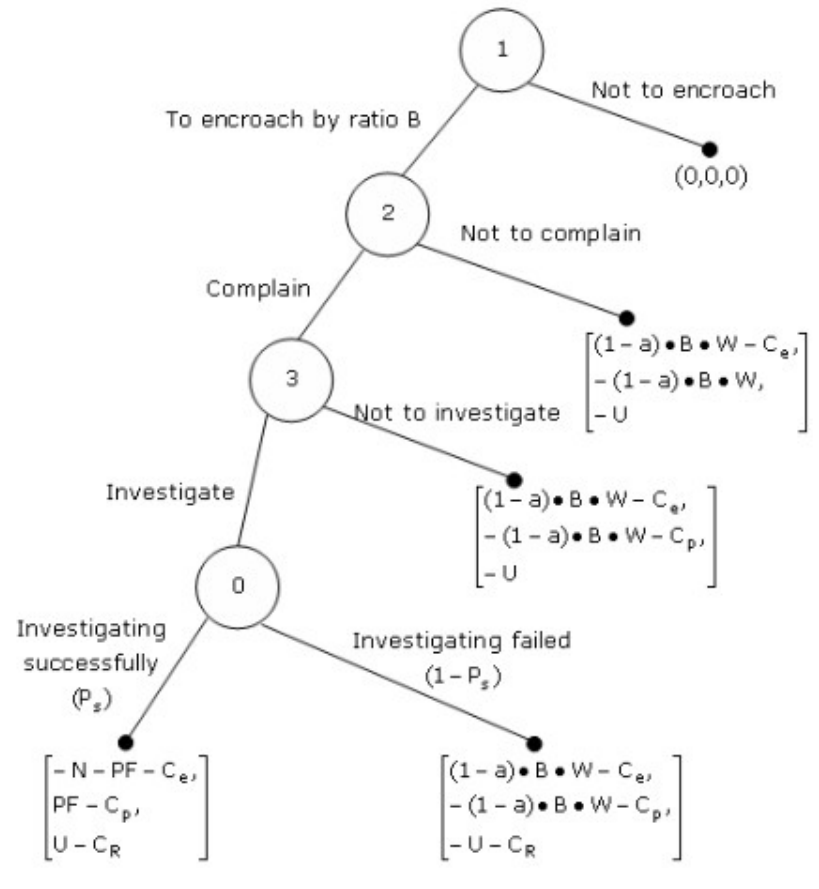
Figure 1. The structure of the